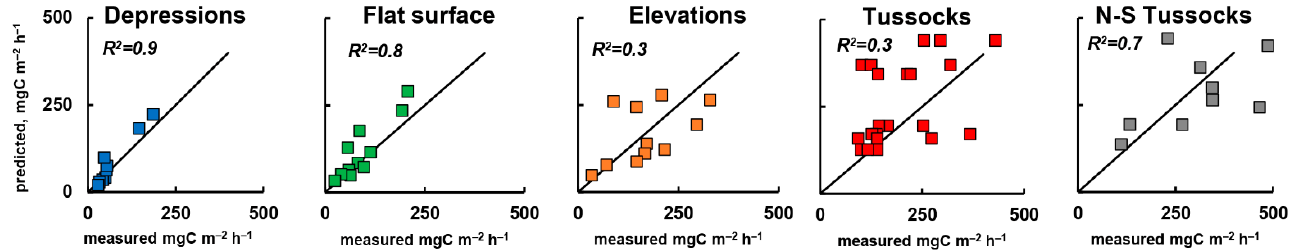
Figure 6. Cross validation of R soil model. X-axis—measured values and Y-axis—predicted values (mgC m –2 h –1 ).